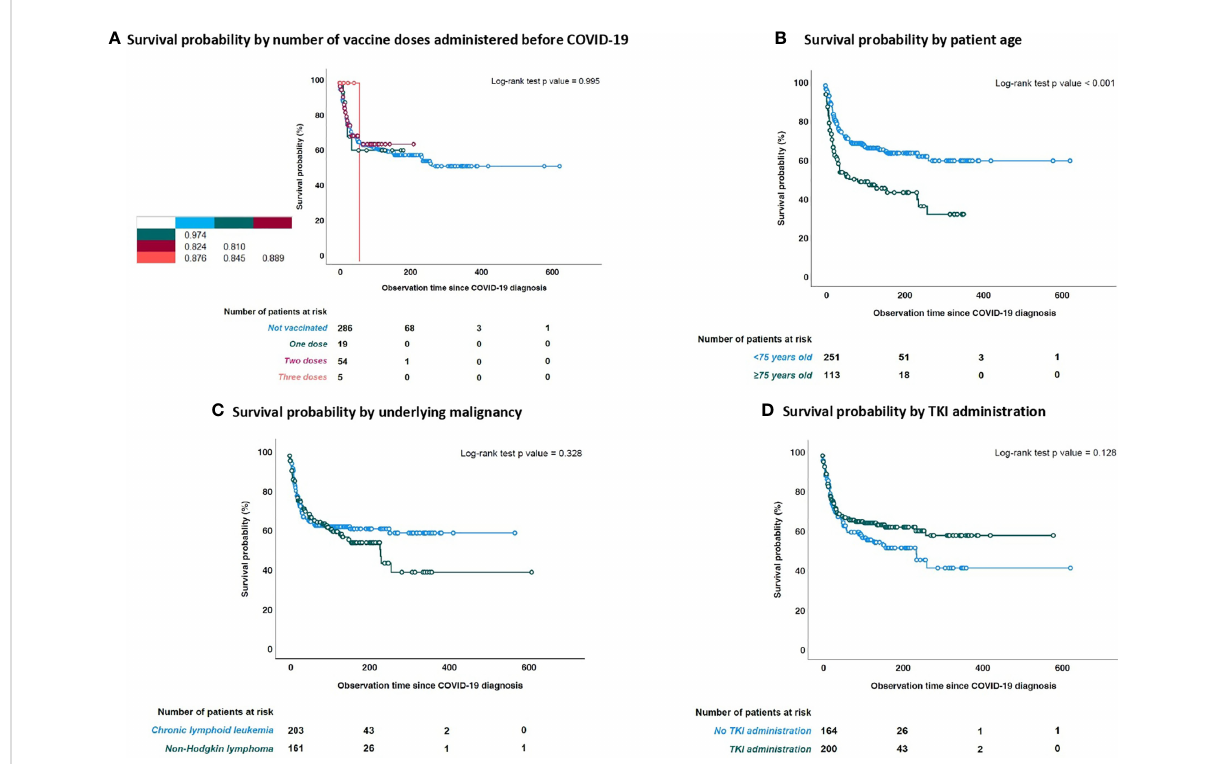
FIGURE 4 Survival probability (SP) from time of COVID-19 diagnosis strati fi ed by number of vaccine doses, age, underlying malignancy and use of BKi at time of COVID-19 diagnosis. (A) SP strati fi ed by number of vaccine doses administered; (B) SP strati fi ed by age; (C) SP by underlying malignancy; (D) SP by BKi